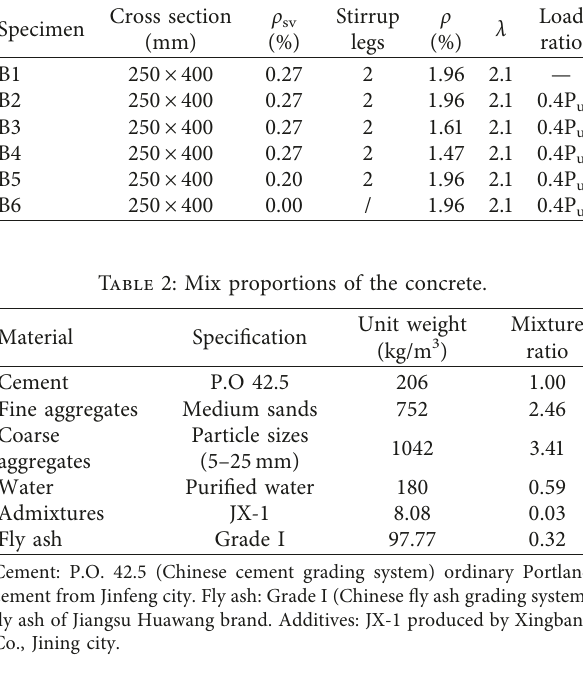
Table 3: Mechanical properties of reinforcement.